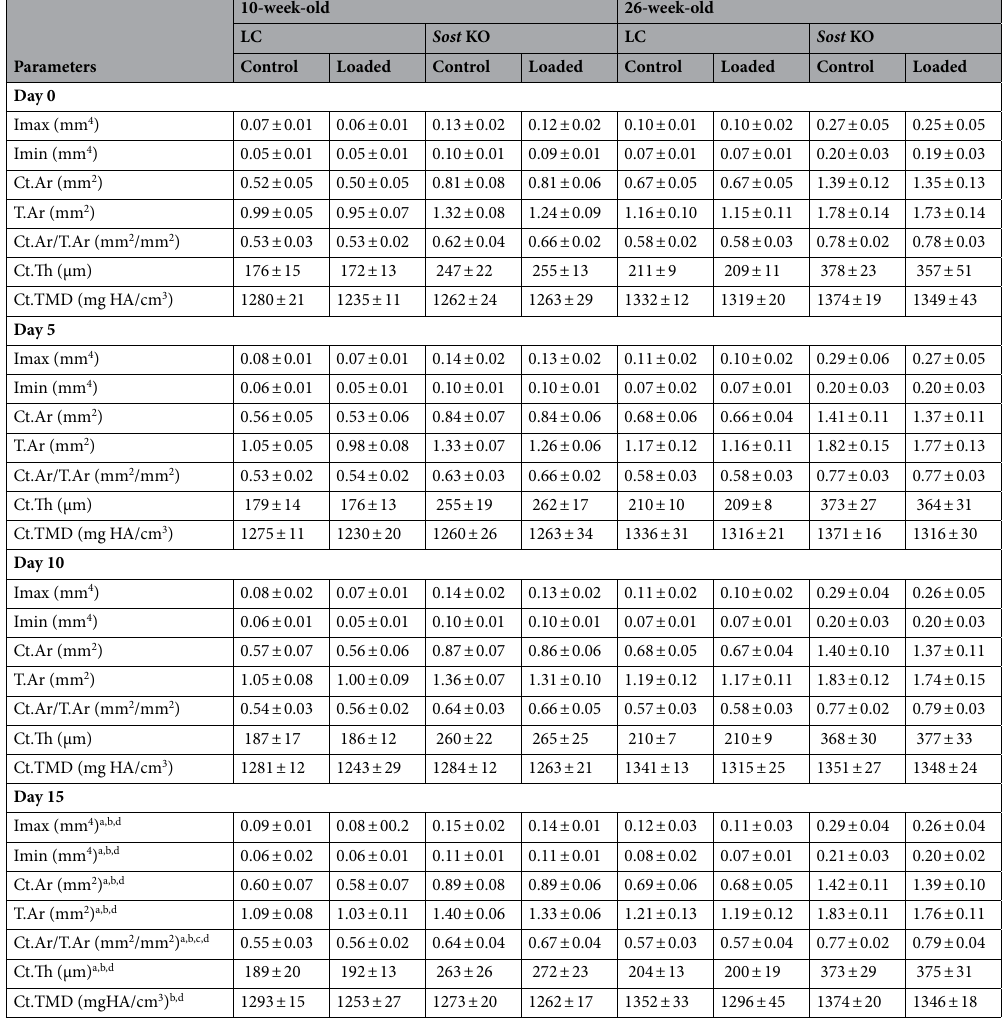
Table 1. Cortical bone parameters of the tibial midshaft, measured from in vivo microCT at day 0, 5, 10 and 15, in 10- and 26-week-old LC and Sost KO male mice exposed to axial tibial compression (left tibia loaded, right tibia nonloaded control). Data are given as mean ± SD. ANOVA: indicates an effect of ( a ) genotype, ( b ) age, ( c ) loading, ( d ) genotype & age, ( e ) genotype & loading, ( f ) age & loading, p <